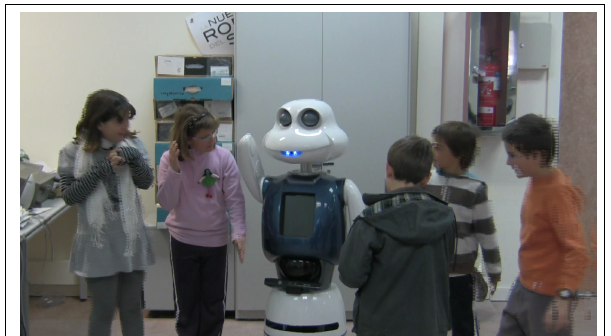
Figure 5. Children mimic robot